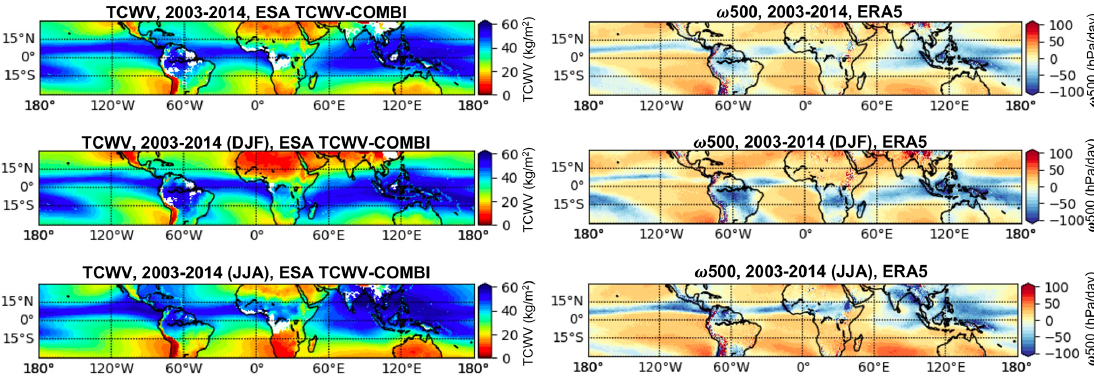
Figure 2. Maps of the TCWV-COMBI (in kgm − 2 ) during 2003–2014 for the tropical region (30 ◦ S–30 ◦ N) for the whole period, winter (December, January and February – DJF) and summer (June, July and August – JJA) and the corresponding maps of ERA5 ω 500 (in hPad − 1